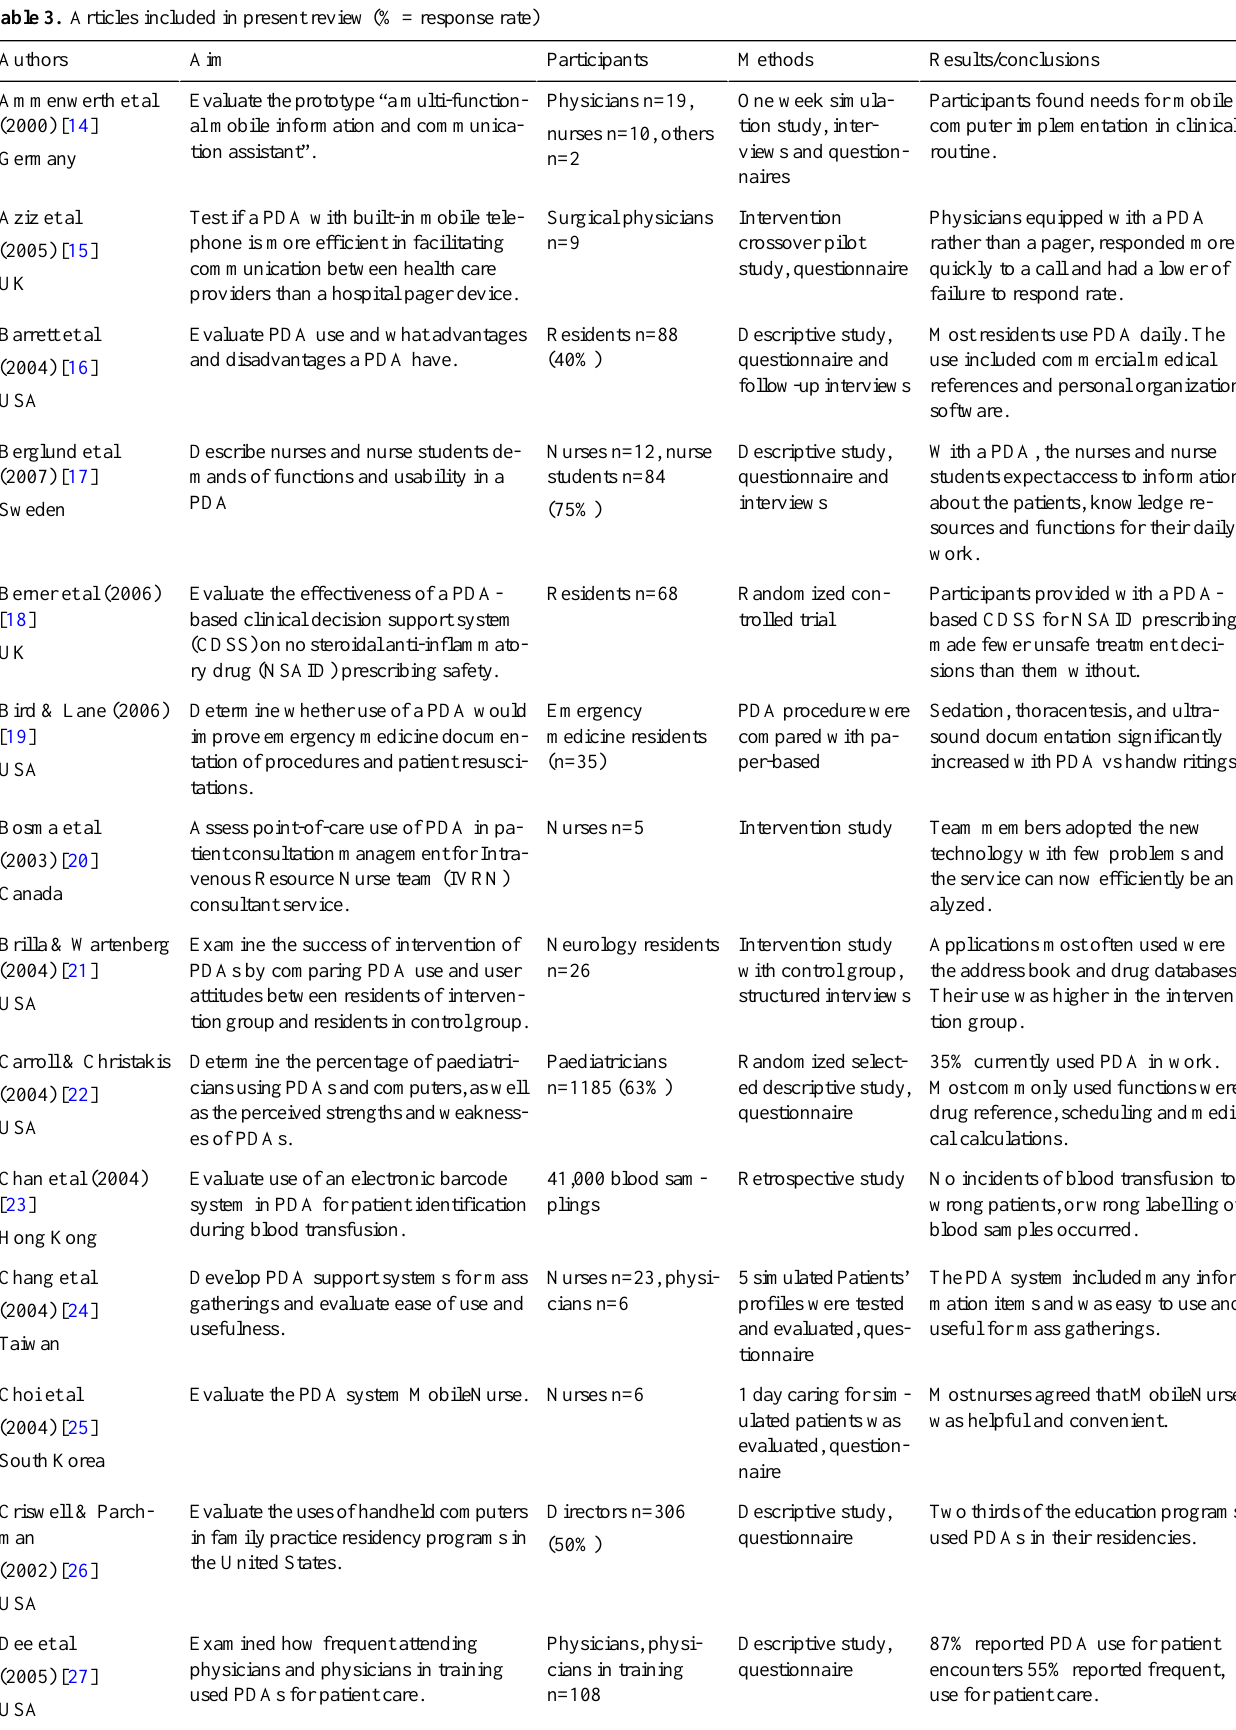
Table 3. Articles included in present review (% = response rate)